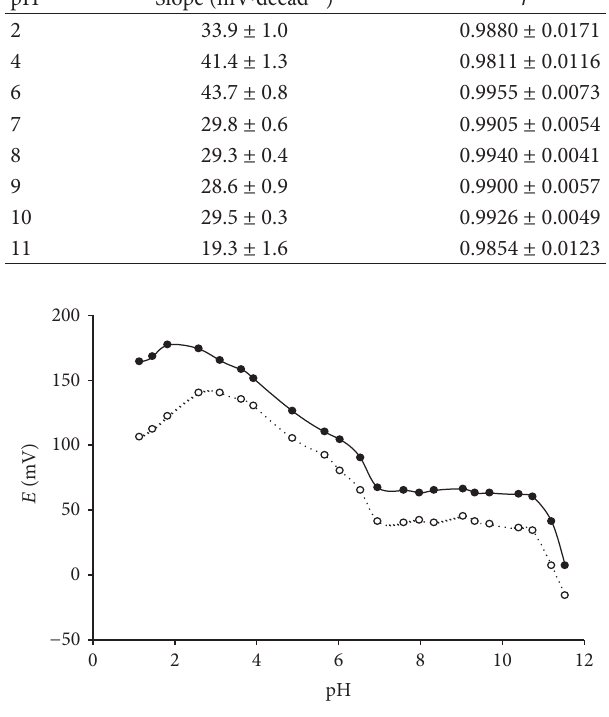
F6:In�uenceofpHonthepotentialresponseofthechromate- selective electrode to 1.0